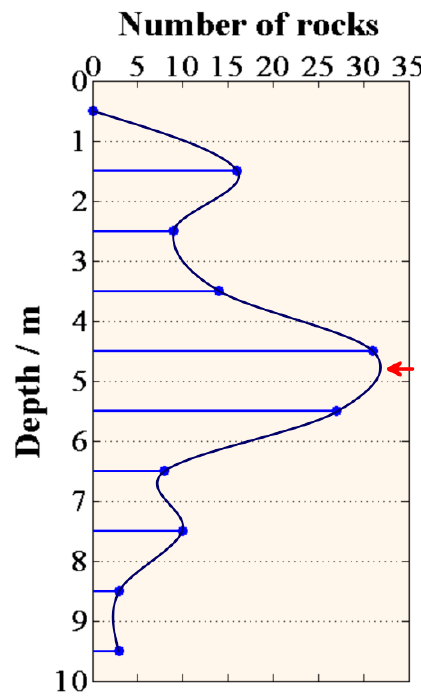
Figure 15. Analysis between the number of rocks and depth.